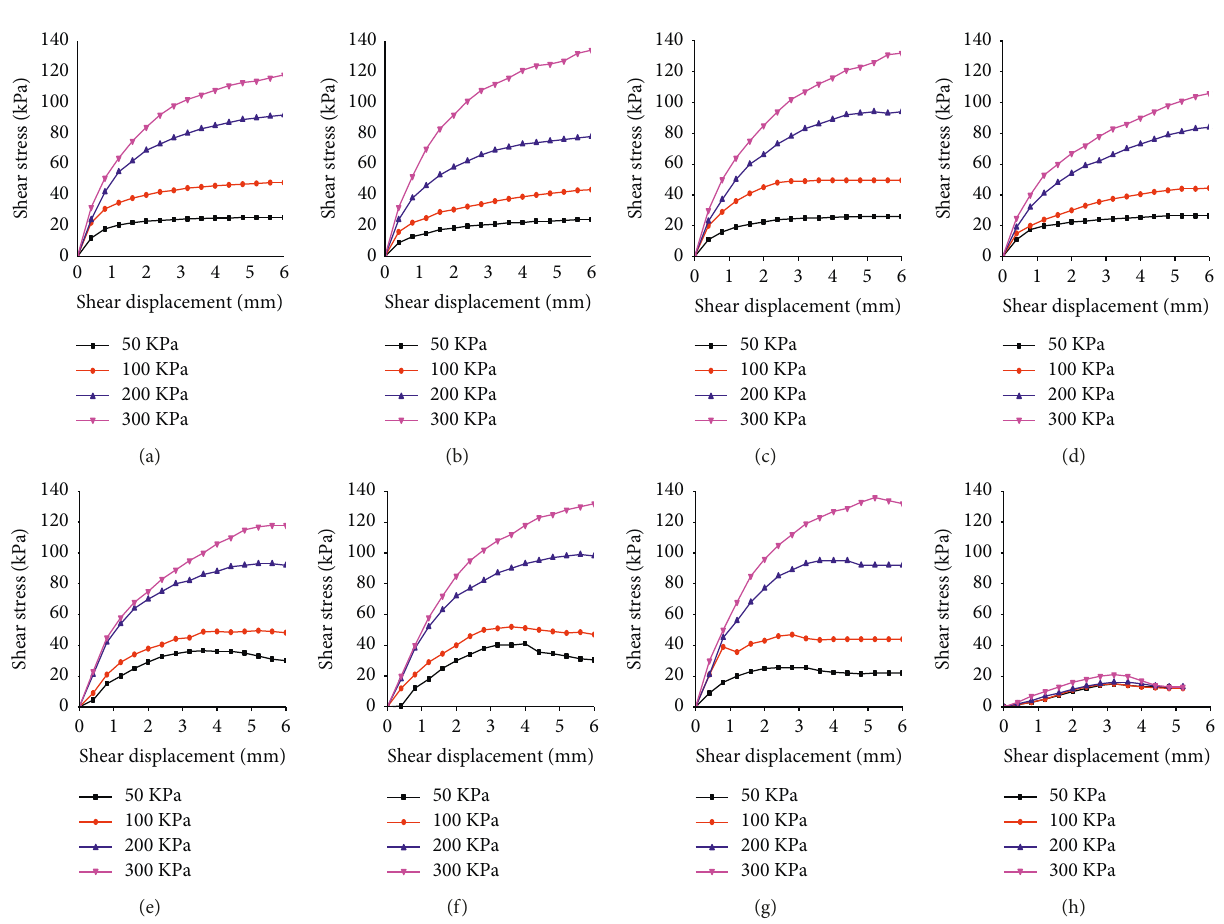
Figure 3: Shear stress-shear displacement curves of the microbial cementation solution-modified loess under different ratios. (a) 10%. (b) 14%. (c) 18%. (d) 22%. (e) 26%. (f) 30%. (g) 34%. (h)